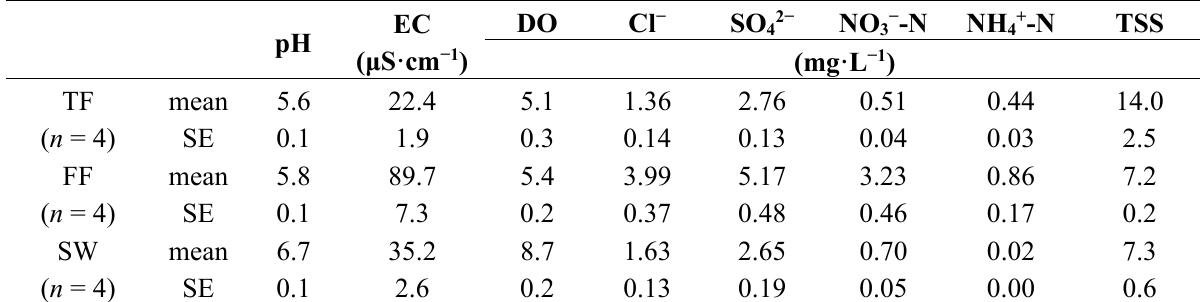
Table 1. Means and standard errors ( n = 4) of volume-weighted mean pH and electrical conductivity (EC) and concentrations of Cl − , SO 42 − , NO 3 − –N, NH 4+ –N, and total suspended solids (TSS) in throughfall (TF), forest floor leachates (FF), and stream water (SW) for the monitoring period from May 2008 to April 2010. Dissolved oxygen (DO). SE indicates standard